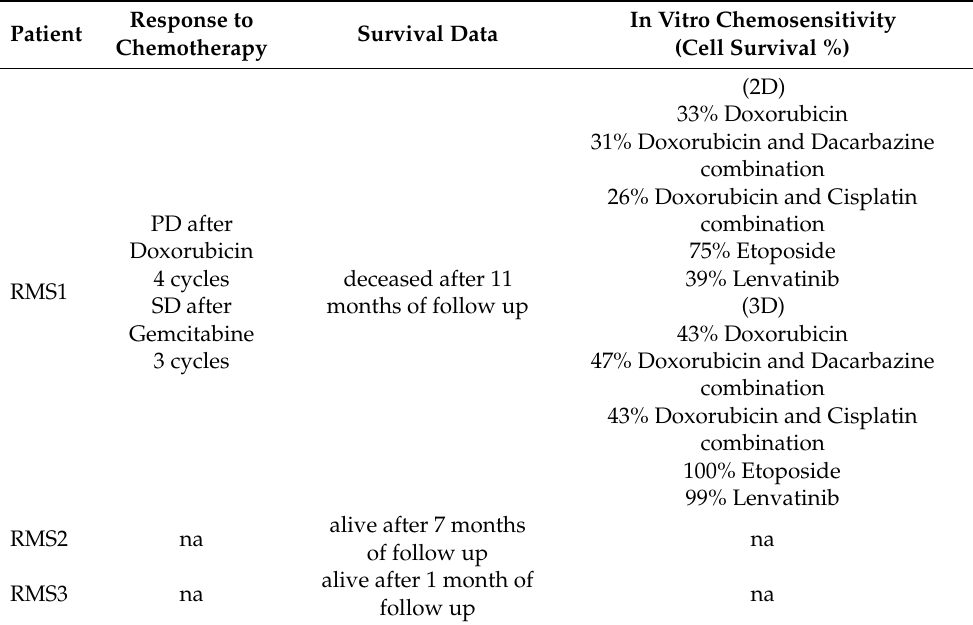
Table 2. Translational comparison between the clinical outcome and in vitro analysis of enrolled